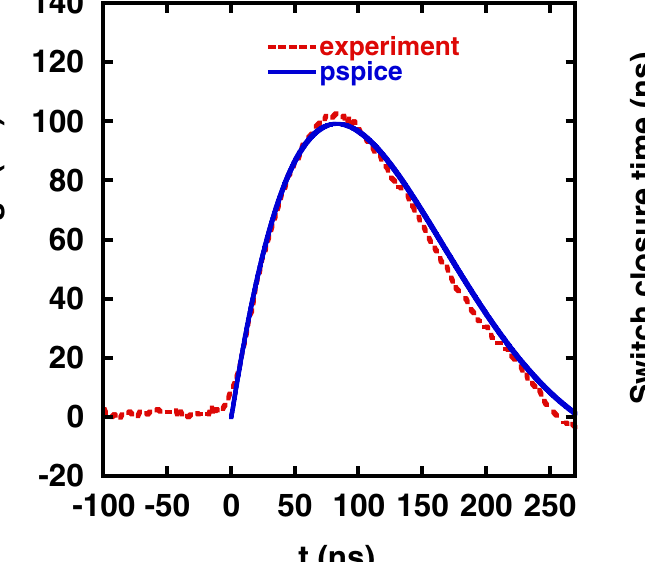
FIG. 13. (Color) Self-break curve of the LTD switches.